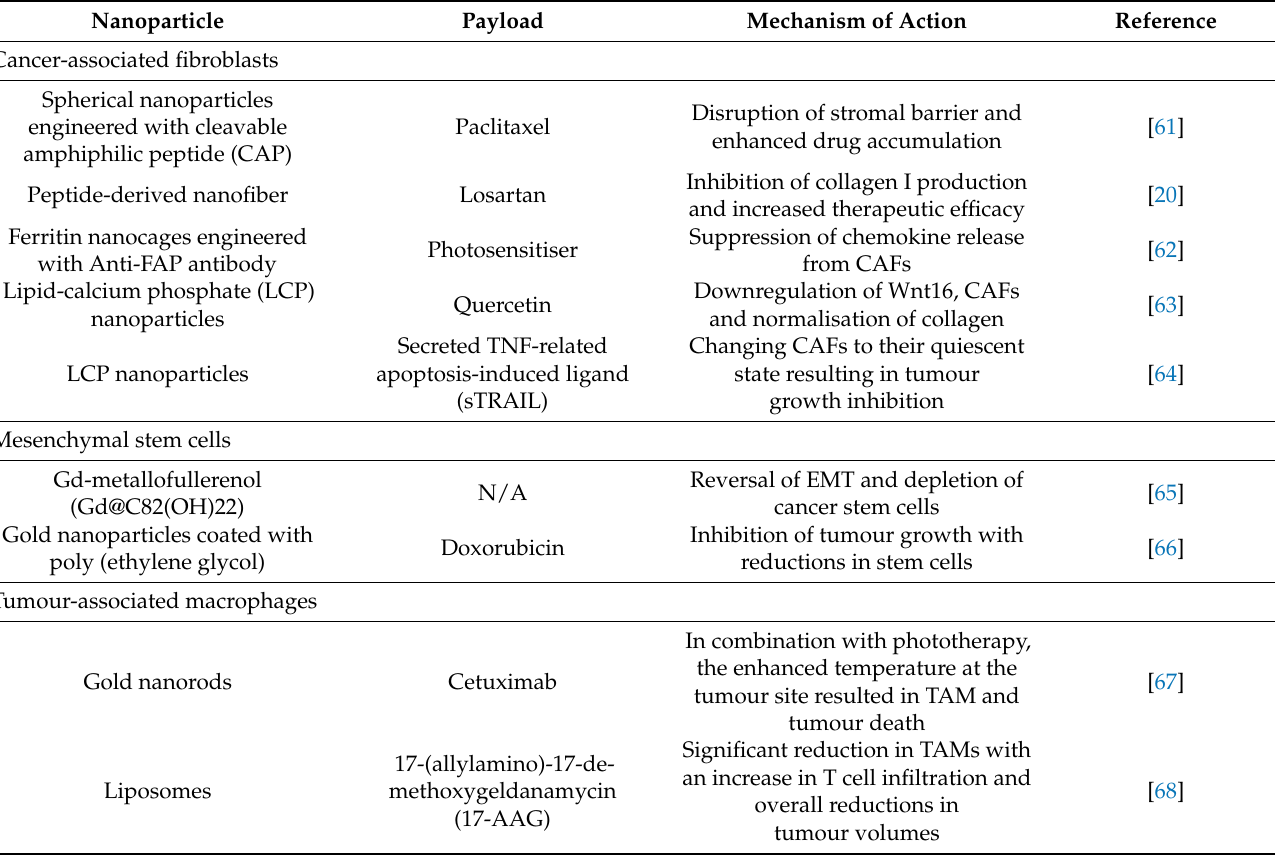
Table 1. Different nanoparticles under investigation impacting TME cell